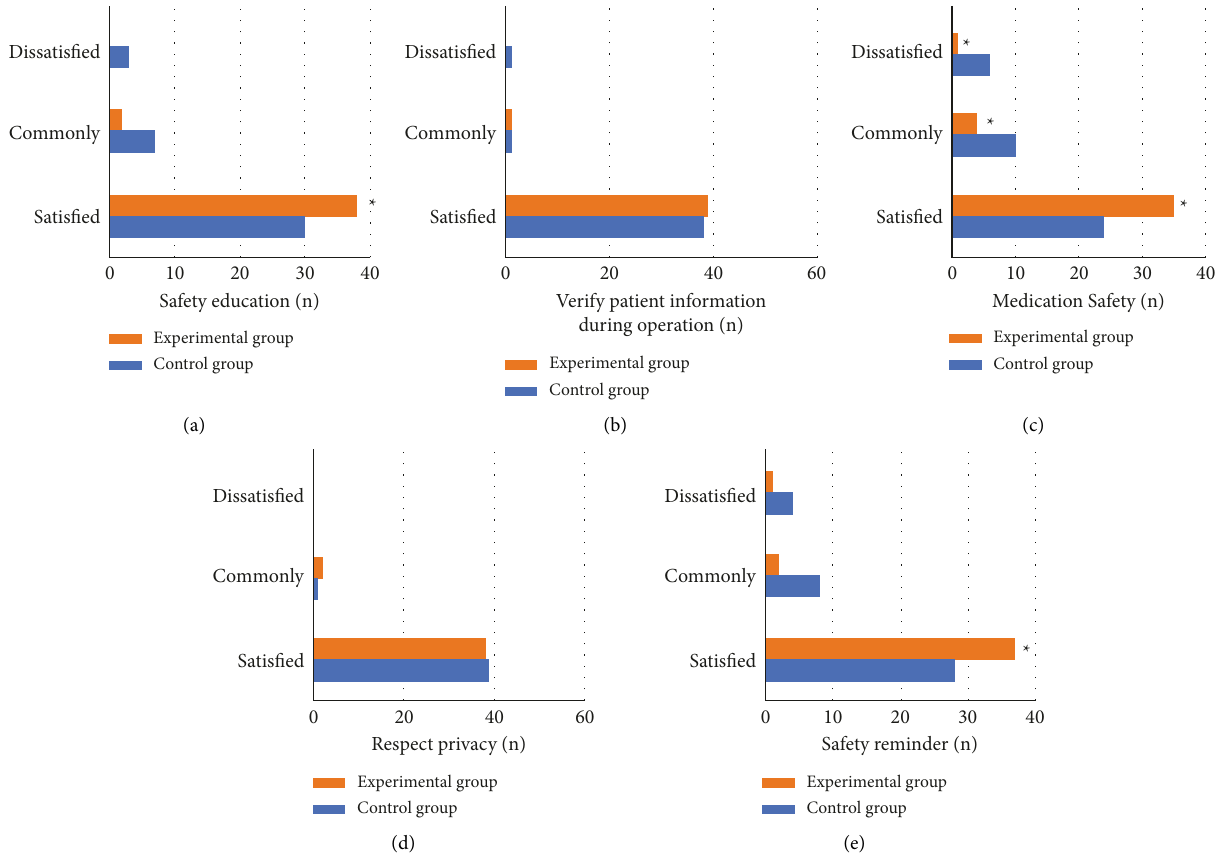
Figure 3: Results of patient satisfaction with safety management. ( Note. ∗ represents a considerable difference vs. control group, P < 0 .